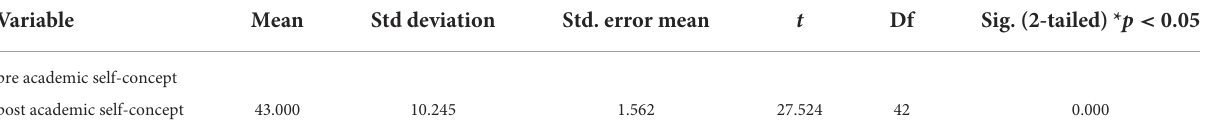
TABLE 6 Sample t- test for pre and post- academic self-concept score. Variable